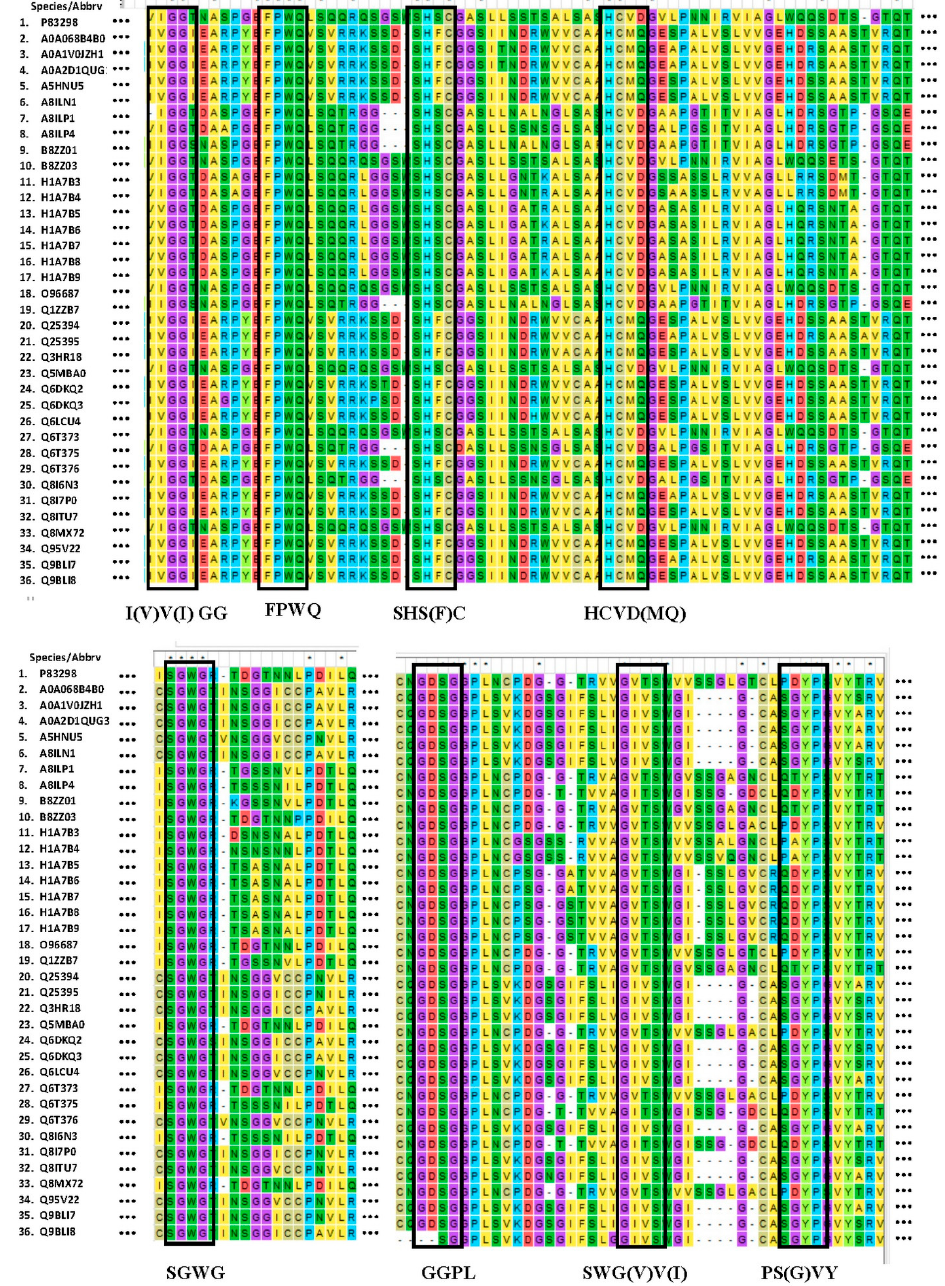
Figure 2. The sequence alignments of LKs. (The meaning of “ ··· ” were the amino acid residues in the LKs sequences that were not shown in the figure.) We downloaded 36 LKs sequences from different earthworm species from the UniProtKB (http://www.uniprot.org/, accessed on 10 May 2020) and U.S. National Center for Biotechnology Information (NCBI) website (https://www.ncbi.nlm.nih.gov/, accessed on 10 May 2020) and compared using the MEGA 7 software. Eight amino acid residues located were identical or similar among the different LK: I(V)V(I)GG, FPWQ, SHS(F)C, HCVD(MQ), SGWG, GGPL, SWV(G)V(I), and